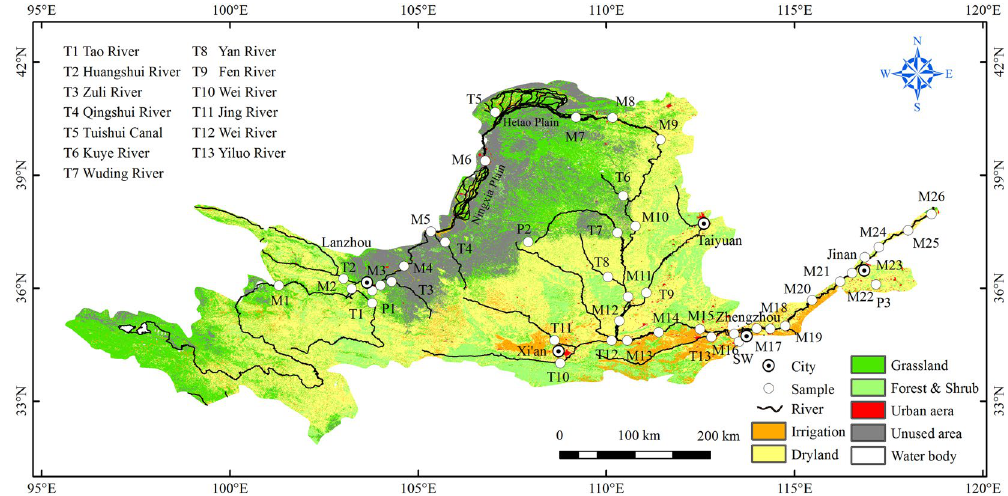
Figure 1. Land use of Yellow River Basin and sampling sites where M indicates samples collected from the mainstream; T indicates samples collected from tributaries; P indicates precipitation samples and SW indicates sewage waste). Map produced using ArcGIS software 9.3 (http://www.arcgis.com/features/index.html).